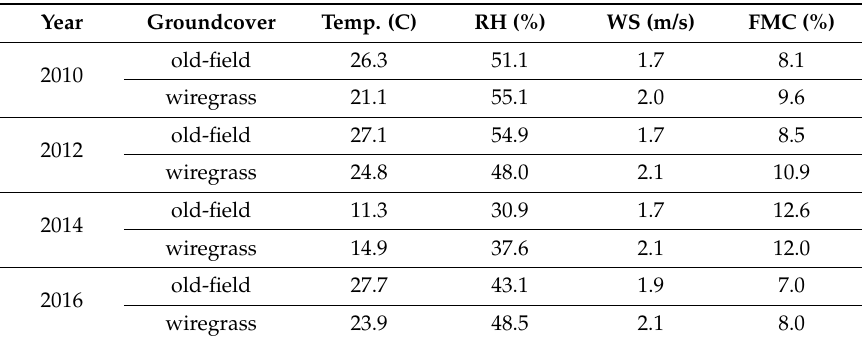
Table 1. Average fire-weather during prescribed